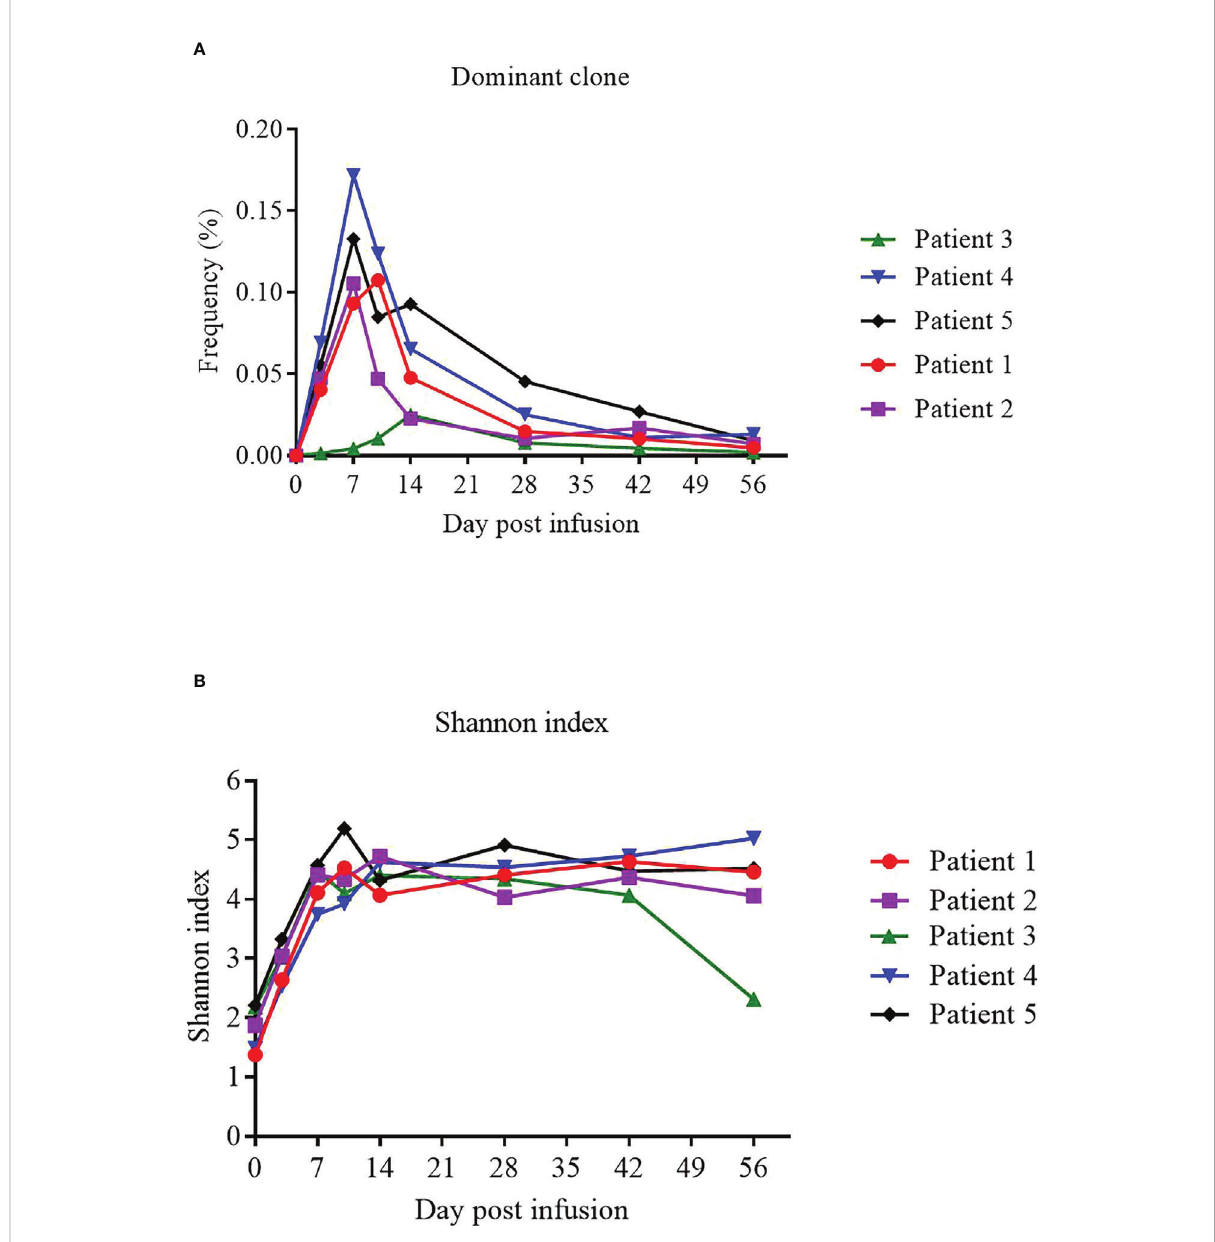
FIGURE 5 Expansion of the dominant TCR clones from infused NAHTC products and patients ’ TCR sequence diversity after NAHTC infusion. (A) The peak expansion of the dominant TCR clones appeared in the fi rst 1-2 weeks after infusion. No dose-related difference was observed in the in the peak expansion of the dominant TCR clones. (B) Shannon index was signi fi cantly increased at all dose levels after cell infusion. However, the Shannon index of the PR patient who relapsed at 2 months after infusion decreased on day 56, which was consistent with the time of relapse. Shannon index treats each TCR subclone proportionally as their relative